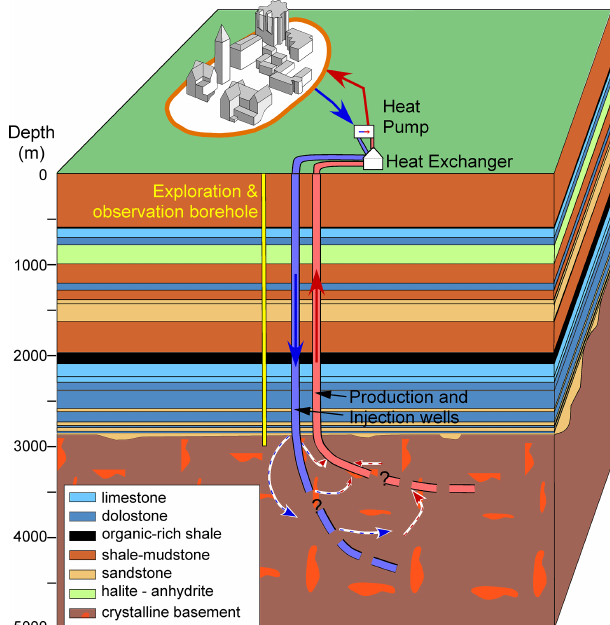
Figure 4. Schematic of the geology beneath Cornell and of the three boreholes recommended by the workshop exercise. An initial bore- hole is recommended as stage 1A (yellow well), which would be dedicated to collection of samples and data and later be transformed into a long-term observatory. Holes 1B and 2 are the other two wells illustrated. Those pilot demonstration wells would be of wider di- ameter, adequate for producing or injecting the large-volume flux needed for a successful geothermal heat project. Perturbations of the near-field subsurface by drilling, testing, stimulating, and pro- ducing the wide-diameter wells would be monitored by equipment installed in the smaller diameter borehole as well as by seismome- ters at the surface and in shallow